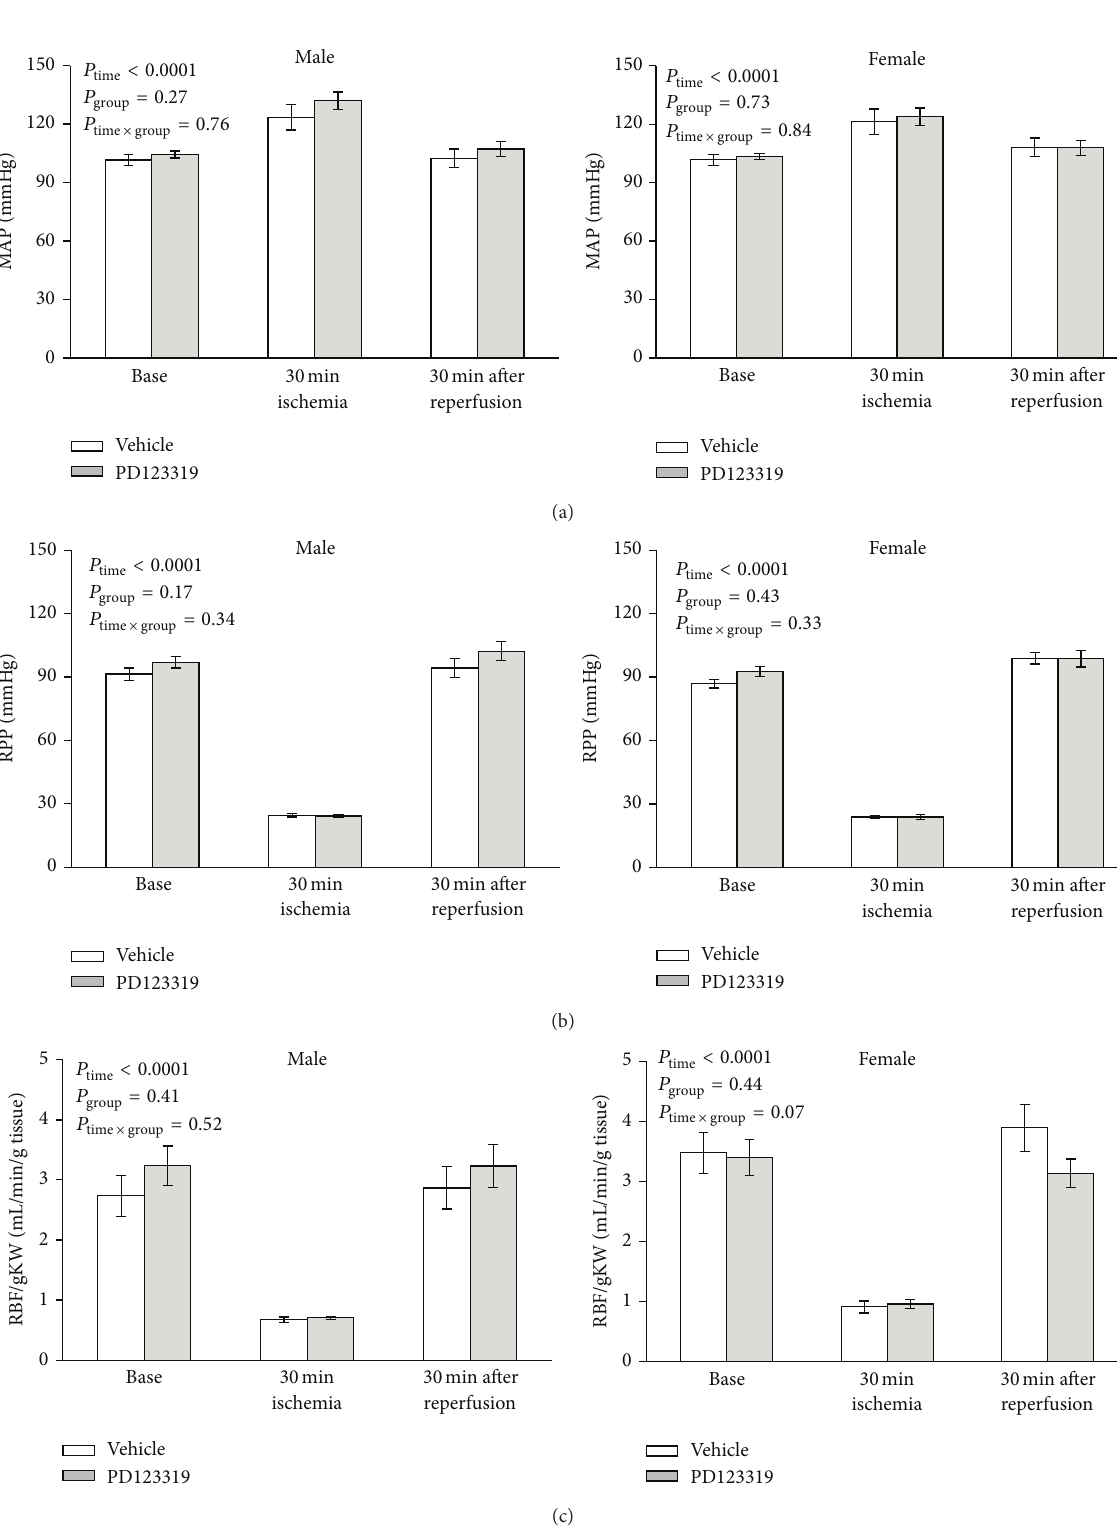
Figure 1: The hemodynamic parameters in male and female rats before ischemia (base), during renal ischemia, and 30 min after reperfusion in two groups of vehicle or AT2R antagonist, PD123319, treatment. The 𝑃 values were derived from repeated measures